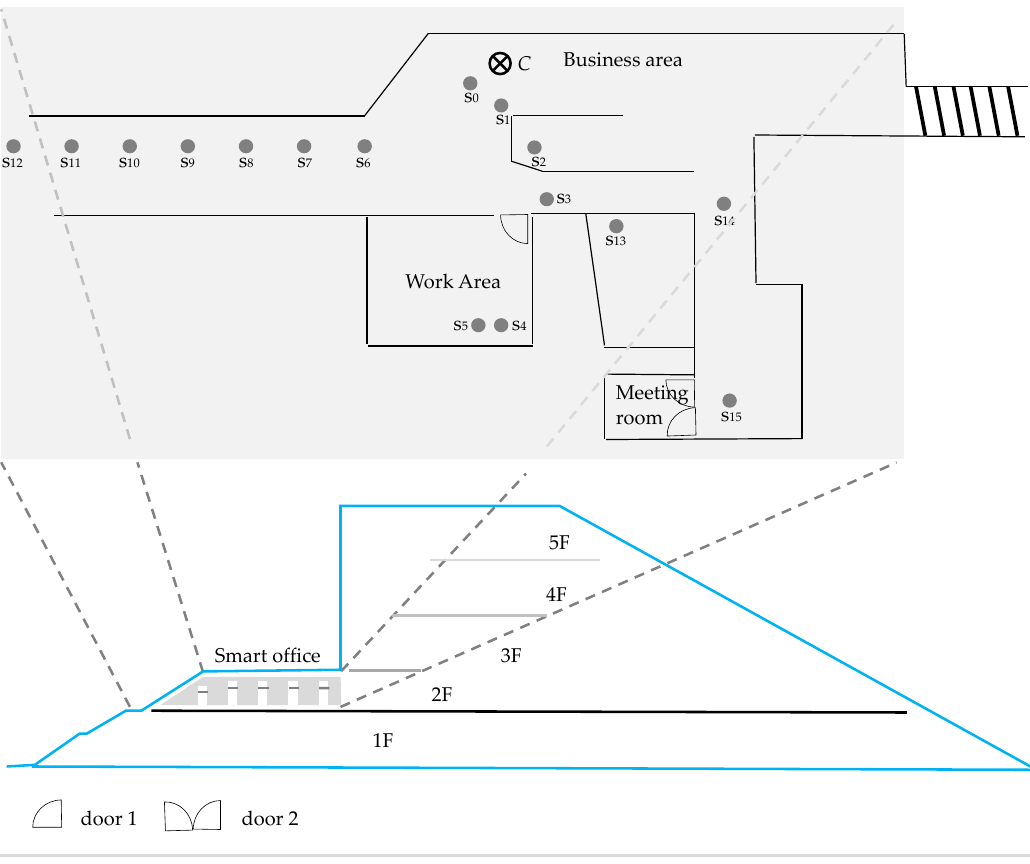
Figure 3. Multiple-embedded-system layout at smart office for indoor floor plane.